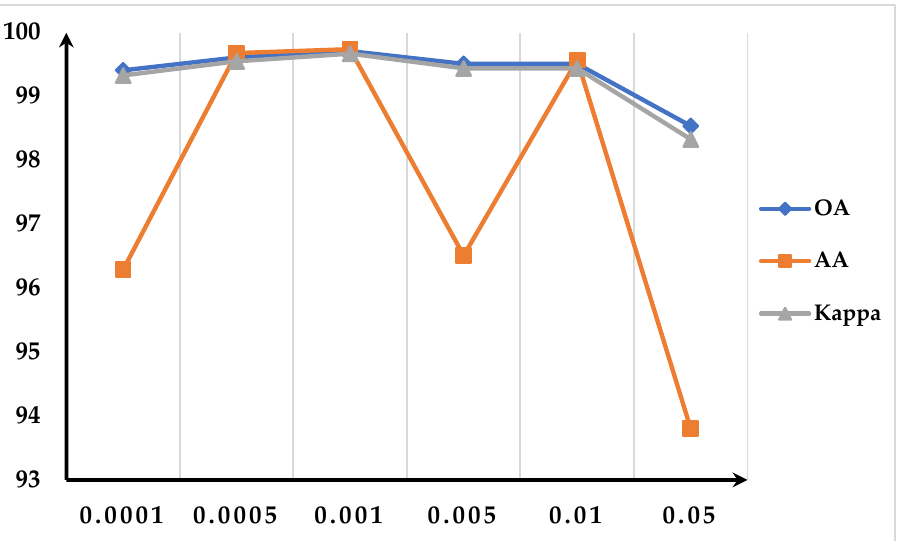
Figure 10. The OA, AA, and Kappa of IP at different learning rates.